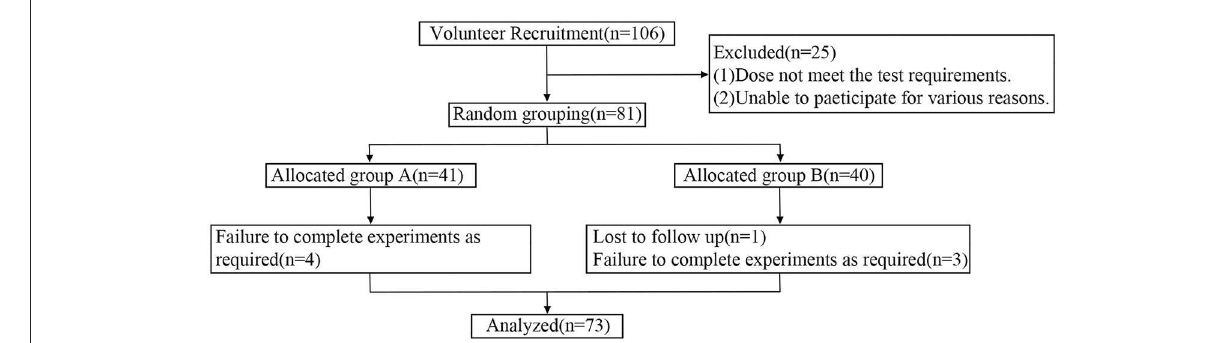
FIGURE1 Flow diagram of participant recruitment and included.